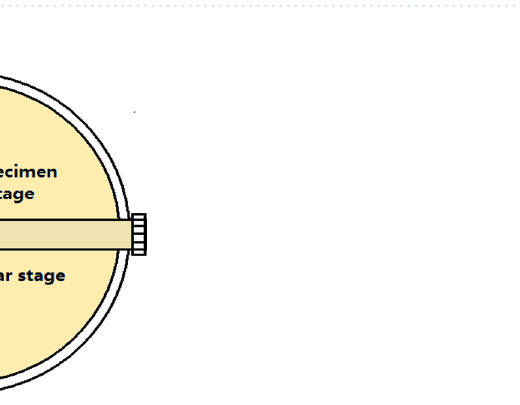
Figure 7. ( a ) LRTM image of the 1D plasmonic periodic structures on silicon surface in the PLE process, ( b ) laser reflecting Talbot magnified image of the 2D plasmonic periodic structures on silicon surface in the PLE process, ( c ) LRTM image of the Wigner electronic crystal with the fourfold (bottom) and the sixfold (top) symmetry lattice on silicon surface in vacuum.